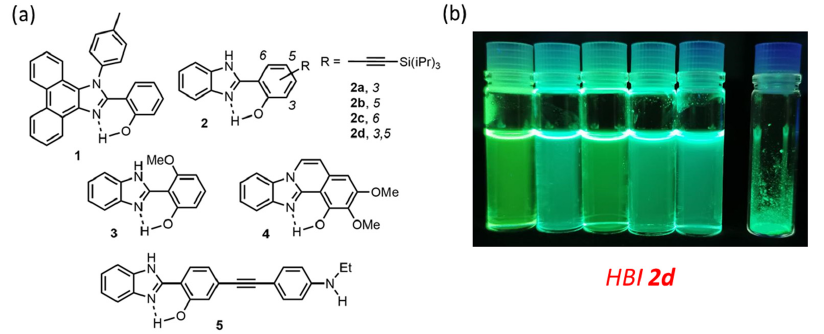
Figure 3. ( a ) Examples of HBI dyes showing DSE properties [61–65] and ( b ) Photographs of 3,5-tri(isopropyl)silyl ethynyl-extended HBI dye 2d under irradiation in solution (toluene, ethanol, THF, acetonitrile and DMF) and as powders ( λ exc = 365 nm) [62]. Adapted from ref [62] Copyright 2021 John Wiley and Sons.